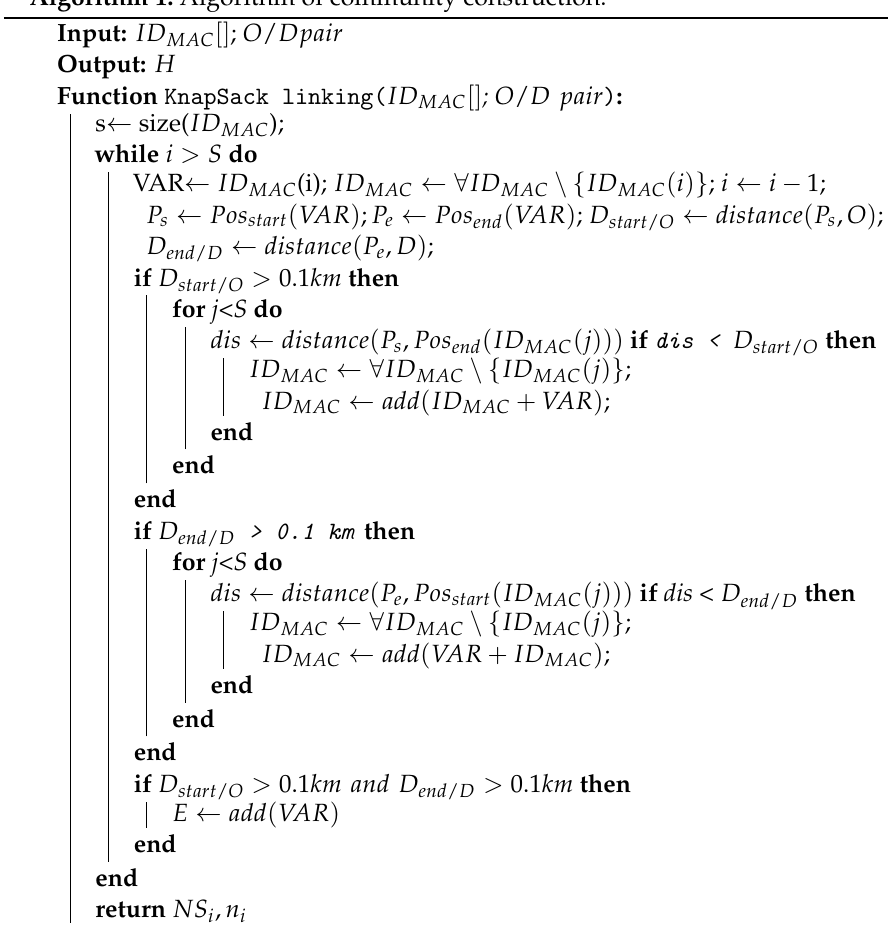
Algorithm 1: Algorithm of community